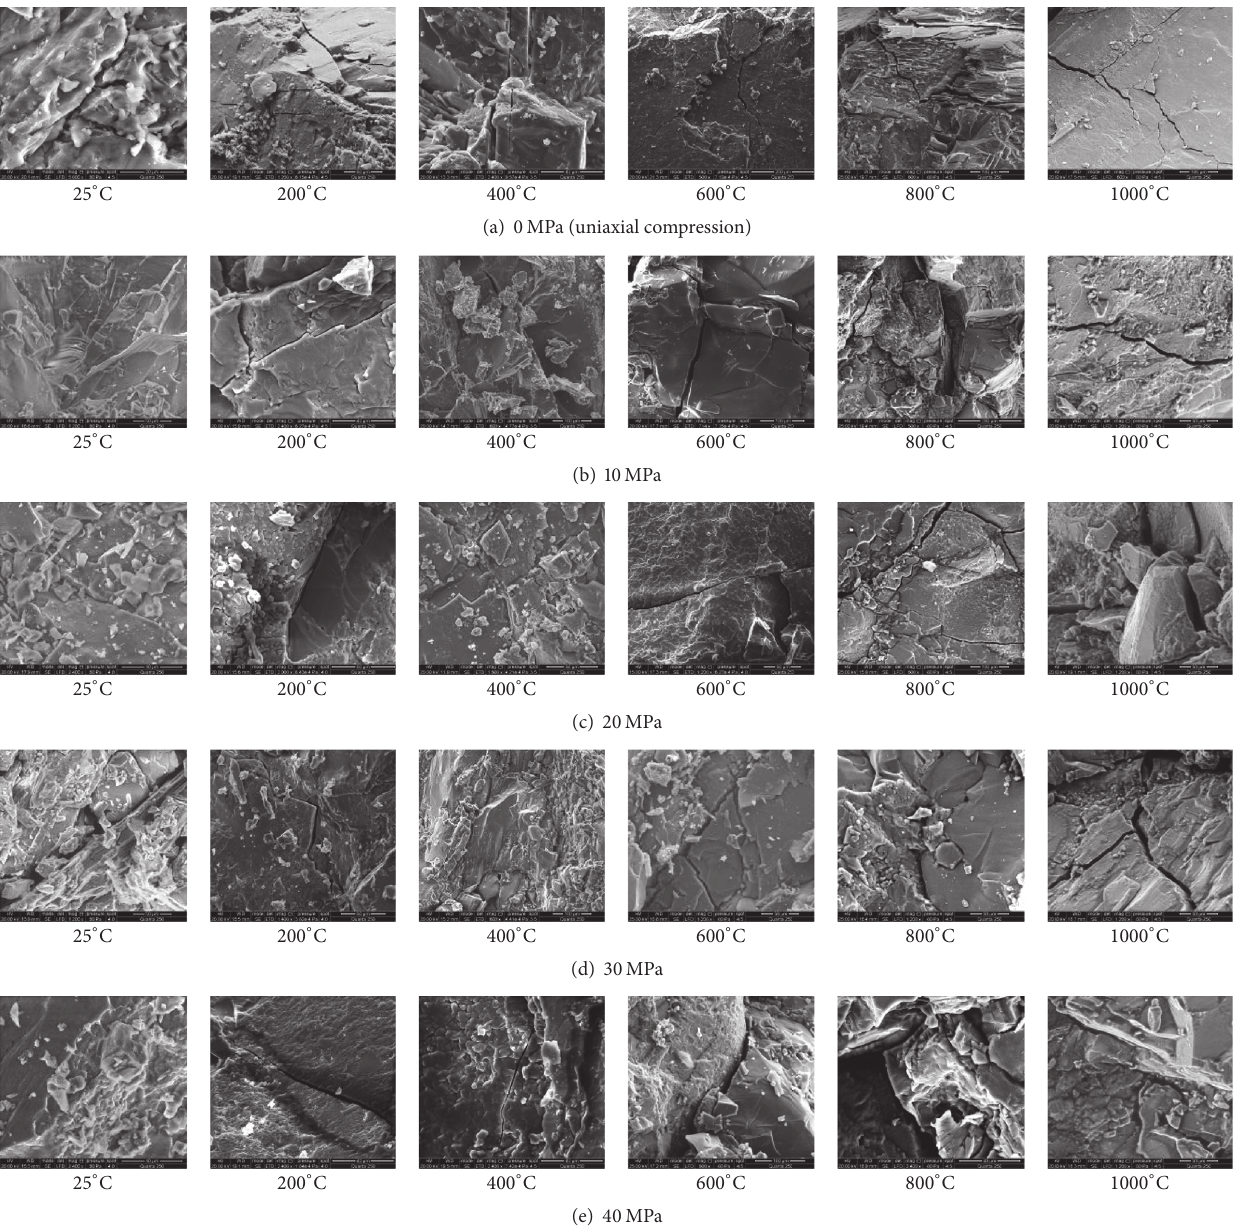
Figure 2: SEM image of rock fracture under different temperature and confining